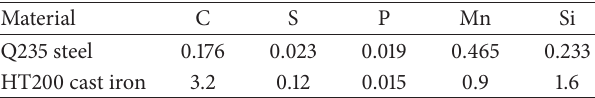
Table 1: Chemical composition of test materials